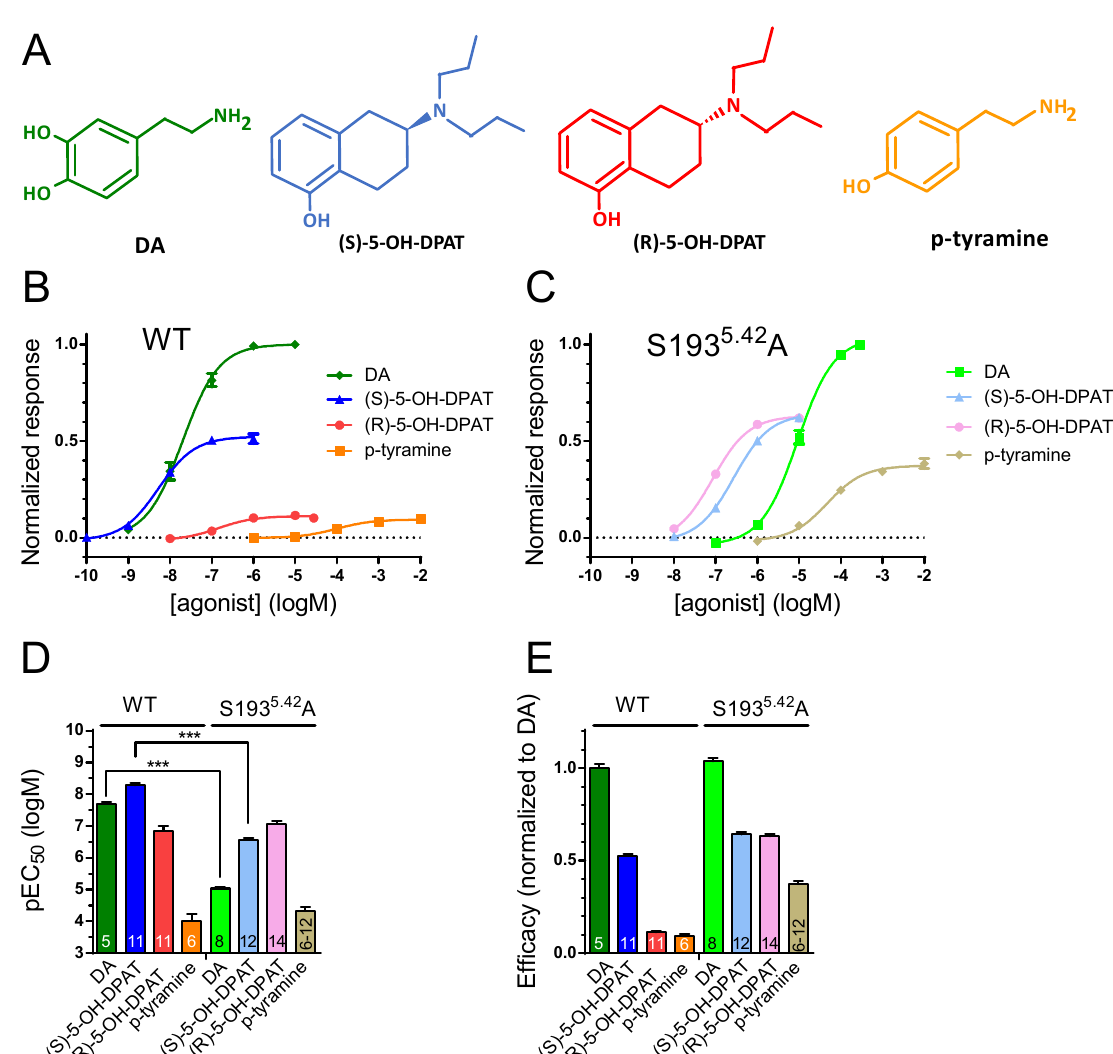
Figure 1. Concentration-response relationships of agonists at WT D 2 R and S193 5.42 A. Concentration–response curves for GIRK activation elicited by application of DA, (S)-5-OH-DPAT, (R)-5-OH-DPAT, and p-tyramine (structures shown in panel ( A )) in oocytes co-expressing GIRK1/4 subunits and RGS4 with ( B ) WT D 2 R and ( C ) D 2 R S193 5.42 A. ( D ) Agonist pEC 50 s at WT and S193 5.42 A D 2 R: pEC 50 for DA (WT: pEC 50 = 7.70 ± 0.07, n = 5; S193 5.42 A: pEC 50 = 5.03 ± 0.04, n = 8), (S)-5-OH-DPAT (WT: pEC 50 = 8.28 ± 0.08, n = 11; S193 5.42 A: pEC 50 = 6.56 ± 0.05, n = 12), (R)-5-OH-DPAT (WT: pEC 50 = 6.85 ± 0.16, n = 11; S193 5.42 A: pEC 50 = 7.07 ± 0.08, n = 14), and p-tyramine (WT: pEC 50 = 4.00 ± 0.21, n = 6; S193 5.42 A: pEC 50 = 4.32 ± 0.12, n = 6–12). Comparison of pEC 50 s using two-way ANOVA yielded significant main effects of agonist (F (3, 65 ) = 281.8) and of the S193 5.42 A mutation (F (1, 65) = 139.2), as well as a significant interaction between these two factors (F (3, 65) = 79.98, p < 0.001 for each main effect). Sidak’s multiple comparisons test further revealed that the pEC 50 s of DA and (S)-5-OH-DPAT, but not p-tyramine and (R)-5-OH-DPAT, differed significantly between WT and mutant D 2 R, as indicated by asterisks; ***, p < 0.001. ( E ) Relative efficacies at WT D 2 R and S193 5.42 A for DA (WT: 1.00 ± 0.02; S193 5.42 A: 1.04 ± 0.04), (S)-5-OH- DPAT (WT: 0.52 ± 0.01; S193 5.42 A: 0.64 ± 0.01), (R)-5-OH-DPAT (WT: 0.11 ± 0.01; S193 5.42 A: 0.63 ± 0.02), and p-tyramine (WT: 0.09 ± 0.01; S193 5.42 A: 0.37 ± 0.01). WT and S193 5.42 A responses were normalized to the response evoked by 1 µ M and 300 µ M DA, respectively. The efficacy values were obtained from the fitted parameter Top, from the corresponding concentration-response curves (see Materials and Methods). The number of oocytes used for each condition is indicated on the bars in ( D , E ) and corresponds to the number recorded to generate the data points plotted in ( B , C ). Experiments were performed using a buffer perfusion rate of 1 mL/min. Data are presented as mean ± SEM.